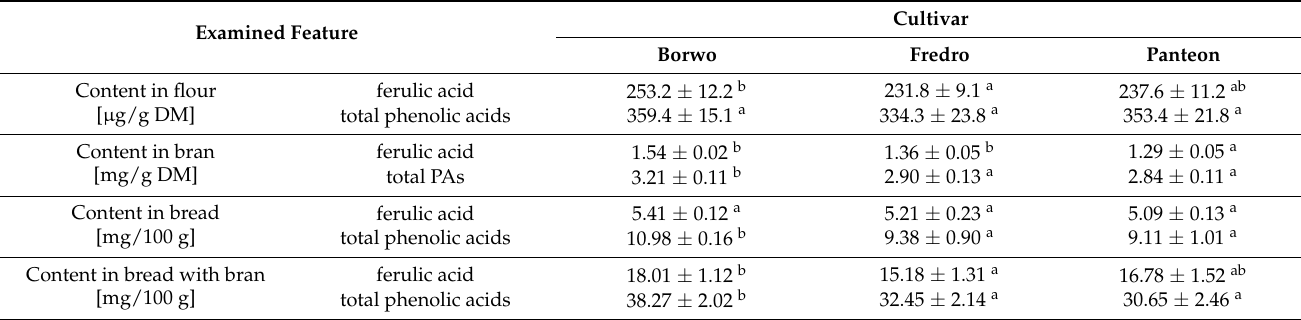
Table 3. The content of PAs in triticale